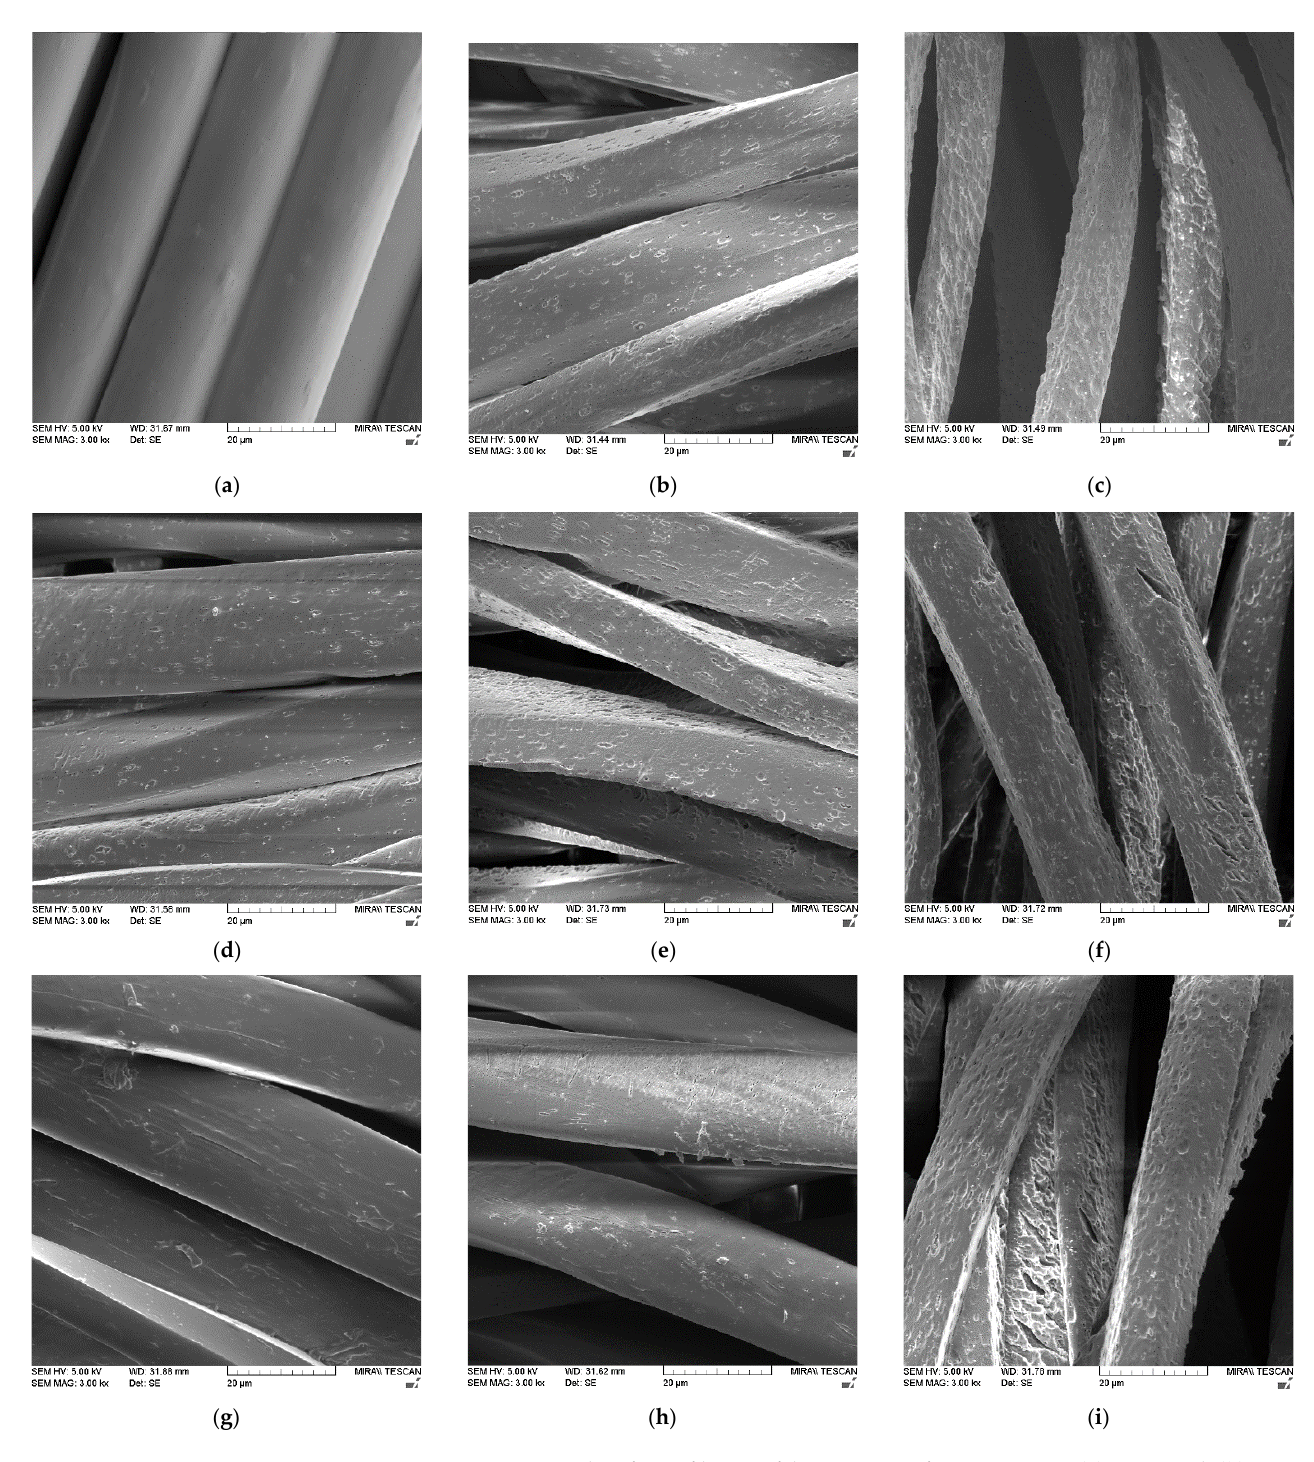
Figure 6. SEM micrographs of PET fibers in fabric at magnification 3000×: ( a ) untreated; ( b ) NaOH + HDTMAC-100 °C–5 ′ ; ( c ) NaOH + HDTMAC–100 °C–30 ′ ; ( d ) NaOH + HDTMAC–80 °C–10 ′ ; ( e ) NaOH + HDTMAC–80 °C–30 ′ ; ( f ) NaOH + HDTMAC–80 °C–60 ′ ; ( g ) NaOH + HDTMAC–60 °C–30 ′ ; ( h ) NaOH + HDTMAC–70 °C–30 ′ ; and ( i ) NaOH + HDTMAC–90 °C–30 ′ . Conventional alkaline hydrolysis, carried out for 60 min at 100 °C, results in a weight loss of 22.12%. The addition of the 1 g cm − 3 of cationic surfactant HDTMAC at 100 °C, the reaction is accelerated, so in 5 min the weight loss is similar (i.e., 20.22%). The reaction time is reduced, which is efficient, but still energetically inefficient. Increasing the pro- cessing time results in increasing weight loss, while at 60 min the samples dissolves com- pletely. Lowering the temperature to 60 °C without adding accelerator has no effect (Fig- ure 3). If HDTMAC is added, and the time is increased, a similar result of 20% weight loss can be obtained at a lower temperature (Figure 4), i.e., at 90 °C in 10 min, at 80 °C in 20 min, and at 70 °C in 45 min. Simultaneously with weight loss, there is a loss of breaking force due to alkali etching of the PET fibers with alkali. Alkaline hydrolysis causes significant loss of breaking force, indicating mechanical damage of fabric for further processing. The acceptable loss of breaking force after processing is 20–40% to maintain wear properties [3,6–17,41]. From Table 1 and Figure 5, it can be noticed that hydrolyzed PET fabric in NaOH for 60 min at 100 °C has a loss of 41.82%, which is on the upper limit. For this reason, PET hydrolysis can be controlled to affect fabrics only as much as necessary (i.e., only surface hydrolysis) in order to improve water wettability without changes to the overall fiber ge- ometry or extensive hydrolysis, resulting in damage to the constituent polymer. These results correlate to previous research on alkaline hydrolysis [3–18,47,48]. However, the results when HDTMAC is used as an accelerator show a similar phe- nomenon as when other cationic surfactants are used, but the dissolution of PET fiber occurs much faster. For example, to achieve the same effect at 100 °C 15 min were required when using Lyogen BPN (fatty acid amino amide by Sandoz), 45 min when using 3- chloro-2-hydroxylpropyltrimethyl ammonium chloride, and 65 min when using Tinegal PAC (quaternary ammonium compound by Ciba) as an accelerator [12,19,55–58]. Com- paring the results to the ones obtained with CPC [21] weight loss is much higher with HDTMAC. The alkali concentration is lower, but also the presence of the aromatic ring in the pyridinium group reduces the surfactant adsorption [59]. The results obtained with CTAB (cetyl trimethylamonium bromide) in terms of weight loss are similar to those ob- tained with HDTMAC at high temperatures when CTAB was used in NaOH with lower concentration (10 g cm − 3 ) at 95 °C [24]. Considering that previous researches using cationic surfactants as accelerators were at temperatures above 90 °C. Similar results for weight loss at 60 °C using HDTMAC as when CTAB was used as an accelerator were found when